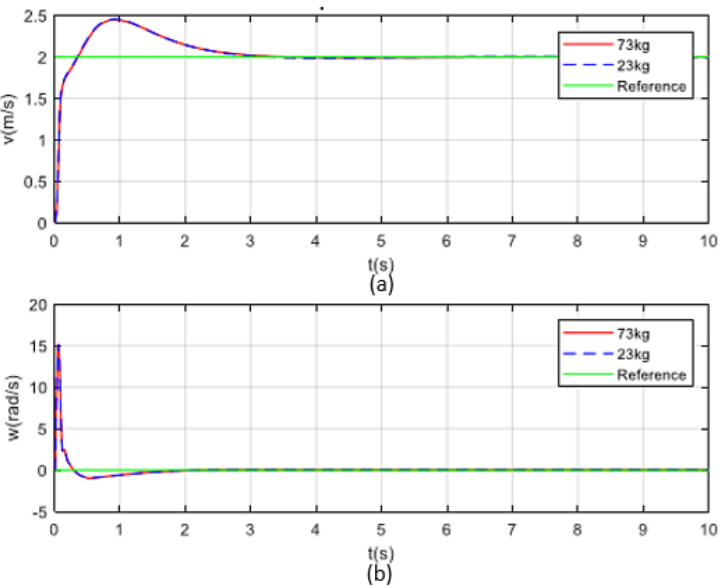
Figure 8. Result of linear velocity ( a ) and angular velocity ( b ) in tracking linear trajectory under varying loads.